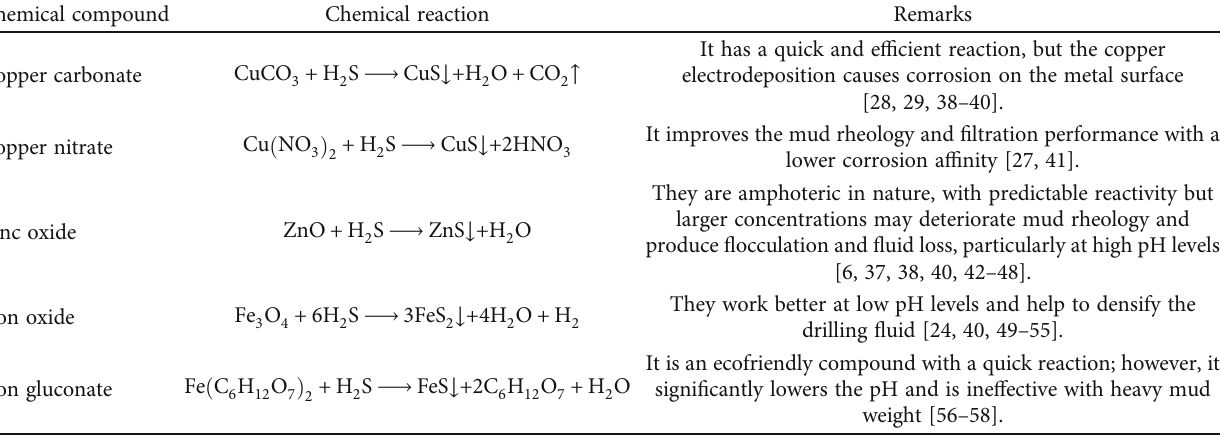
Table 1: Various metal-based scavengers used in drilling operations.